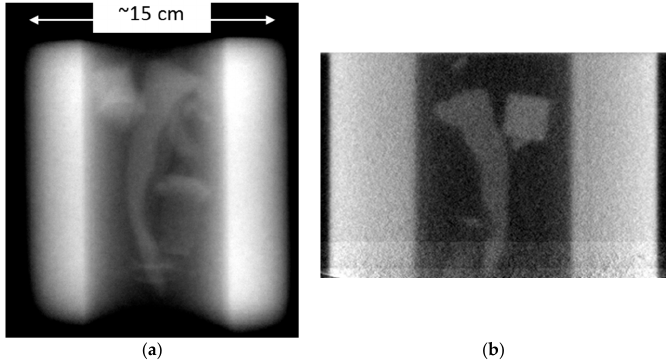
Figure 17. ( a ) A high-energy neutron radiograph of an aluminum alloy chili pepper, an iron pyrite (FeS, “fool’s gold”) double crystal and a pewter figurine of Kokopelli on a stopper inside a depleted uranium cylinder with 4 cm thick walls and dimensions 15.24 cm OD, 7.24 cm ID, 20.3 cm tall, weight 62 kg. ( b ) A CT slice through the center of the cylinder showing the pepper and iron pyrite crystals.